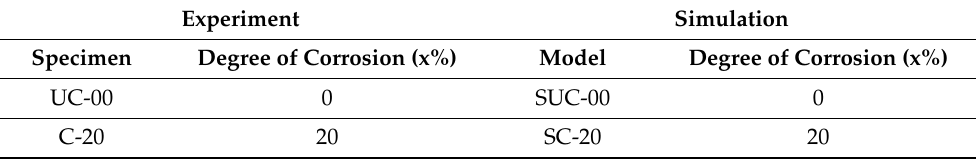
Table 2. Analysis